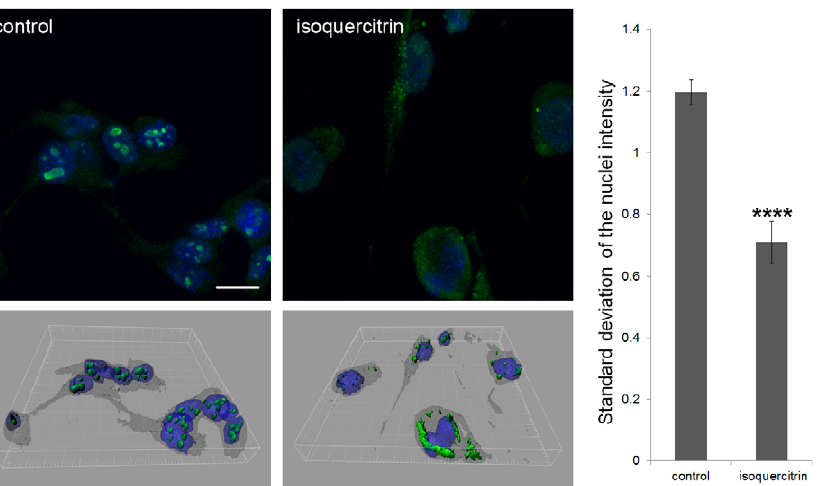
Figure 7. Isoquercitrin causes a change in RhoA localization. Upper left, The fluorescent images (acquired with 63 6 oil objective) show immune-staining of RhoA in 48 hr cultures. Green=RhoA, blue=nuclei. Scale bar=20 micron. Bottom left, 3D projections of z-stack images – obtained with Imaris software - corresponding to 2D images above. Scale bar=15 micron. Right, The bar graph illustrates the standard deviation of the fluorescence in the nuclei normalized by the cytoplasmic fluorescence for each cell. (n=10 images, pair sample t-Test, ****p , 0.0001). Data are shown as means 6 s.e.m.